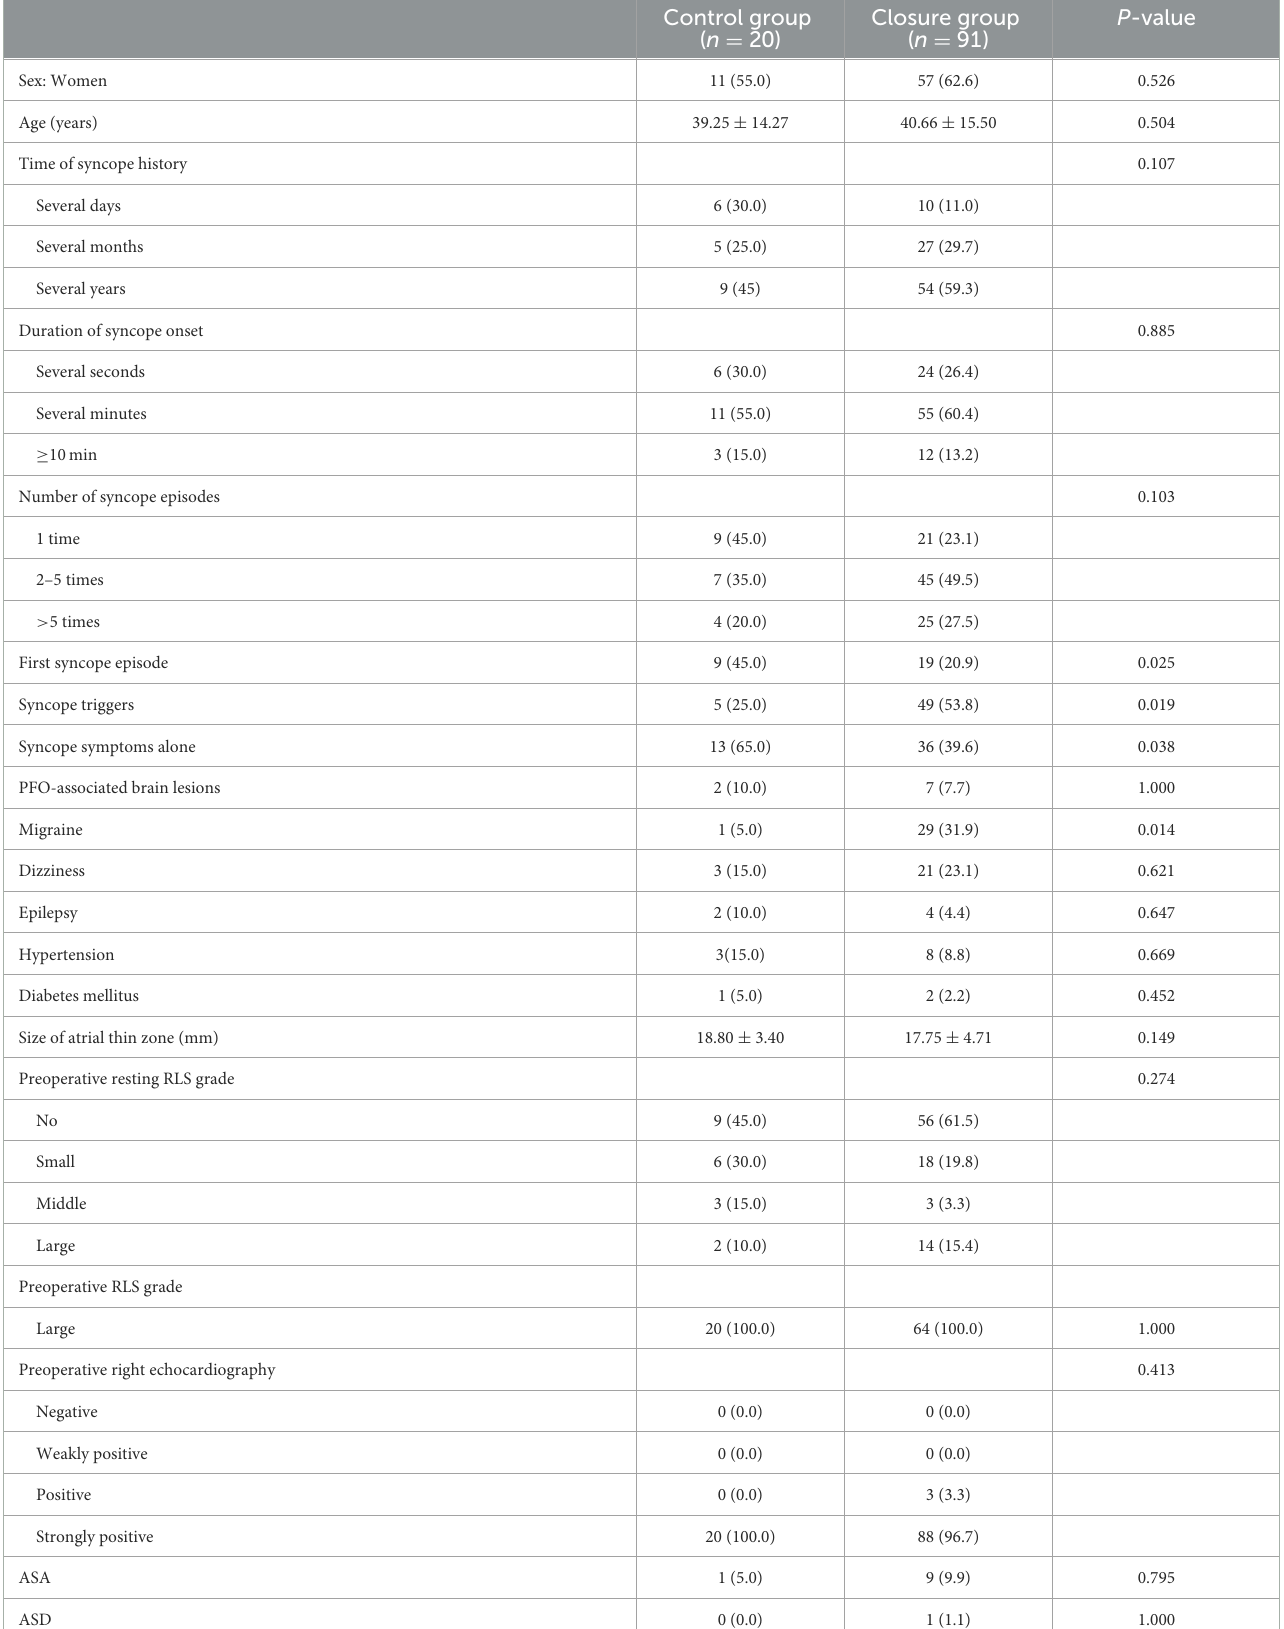
TABLE 1 Comparisons of participant characteristics between the closure group and the control